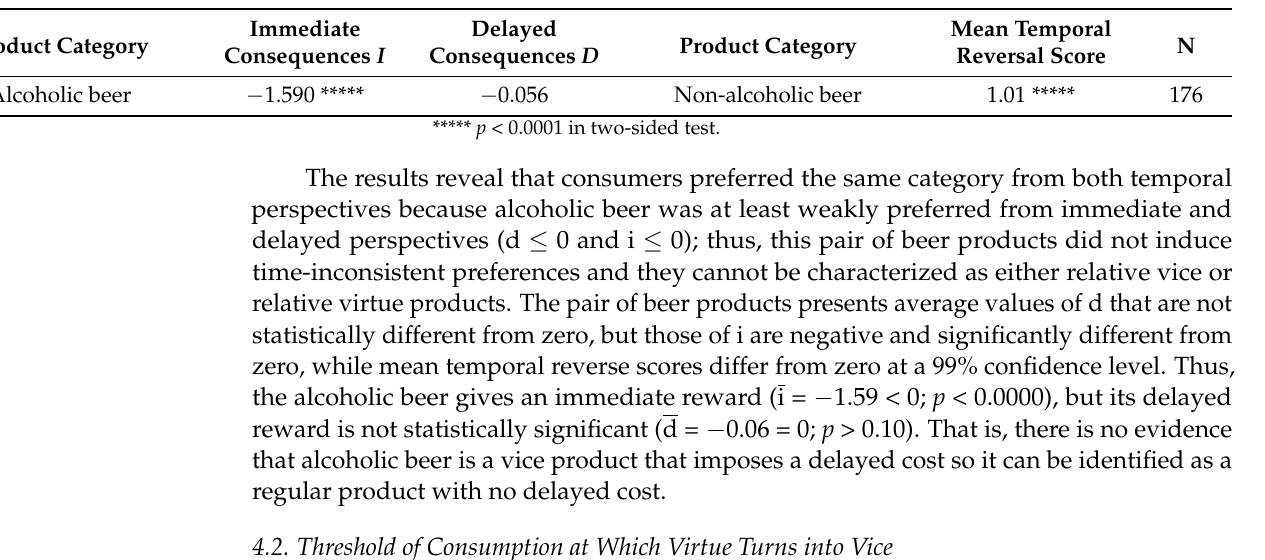
Table 1. Product